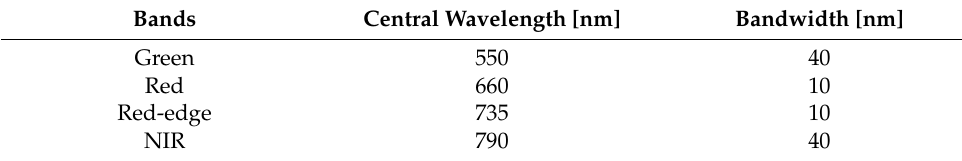
Table 3. Sequoia band characteristics, central wavelength, and bandwidth.